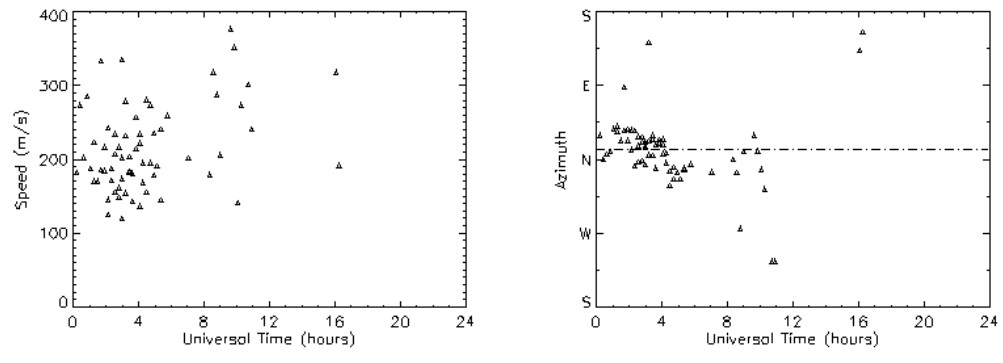
Fig. 10 Fig. 10. Same as Fig. 9, except the reference beam is chosen along beam